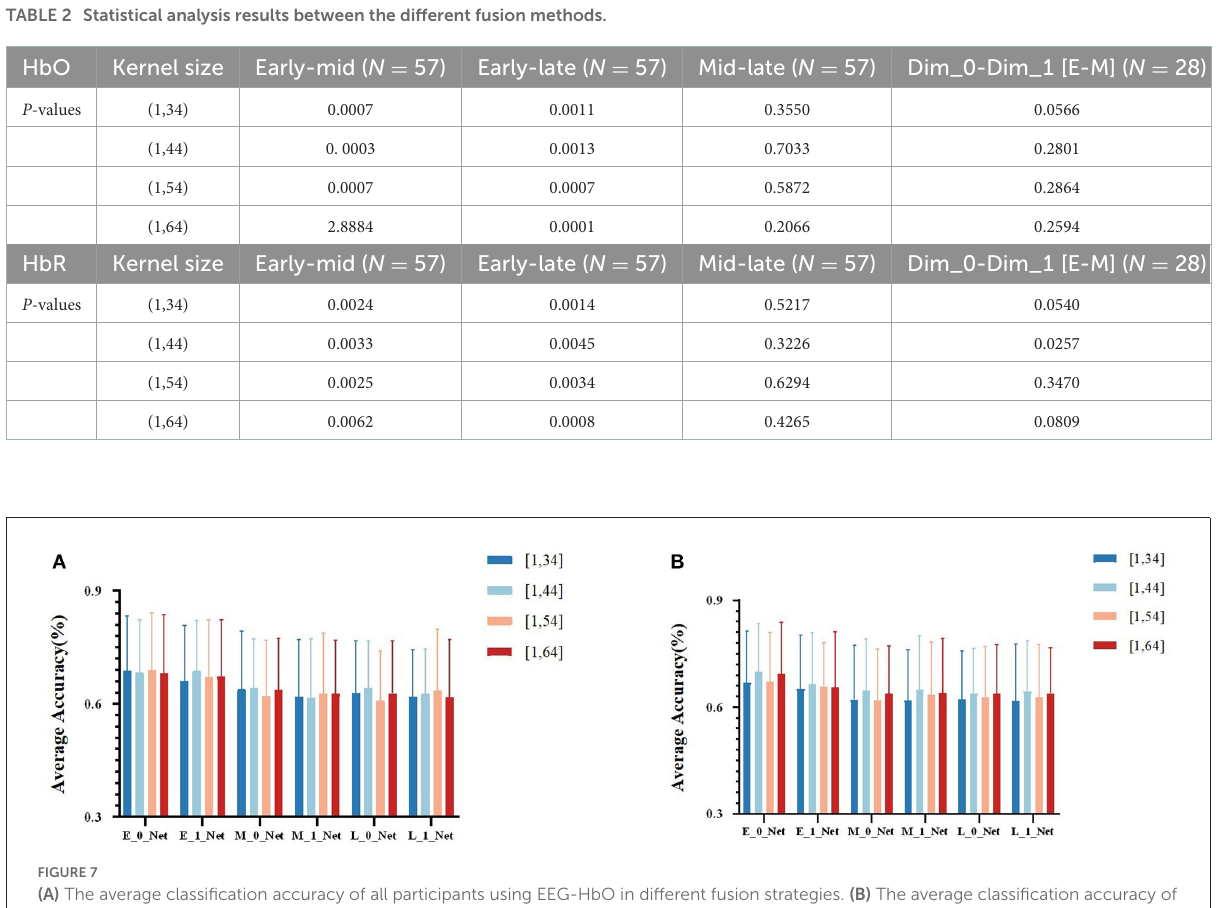
TABLE 2 Statistical analysis results between the different fusion methods.